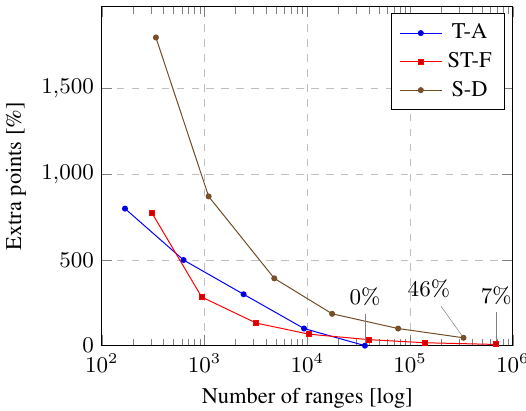
Figure 6: The effect of increasing the depth of the tree on the percentage (%) of extra points obtained during the filtering phase of the integrated approach. The x axis is logarithmic.